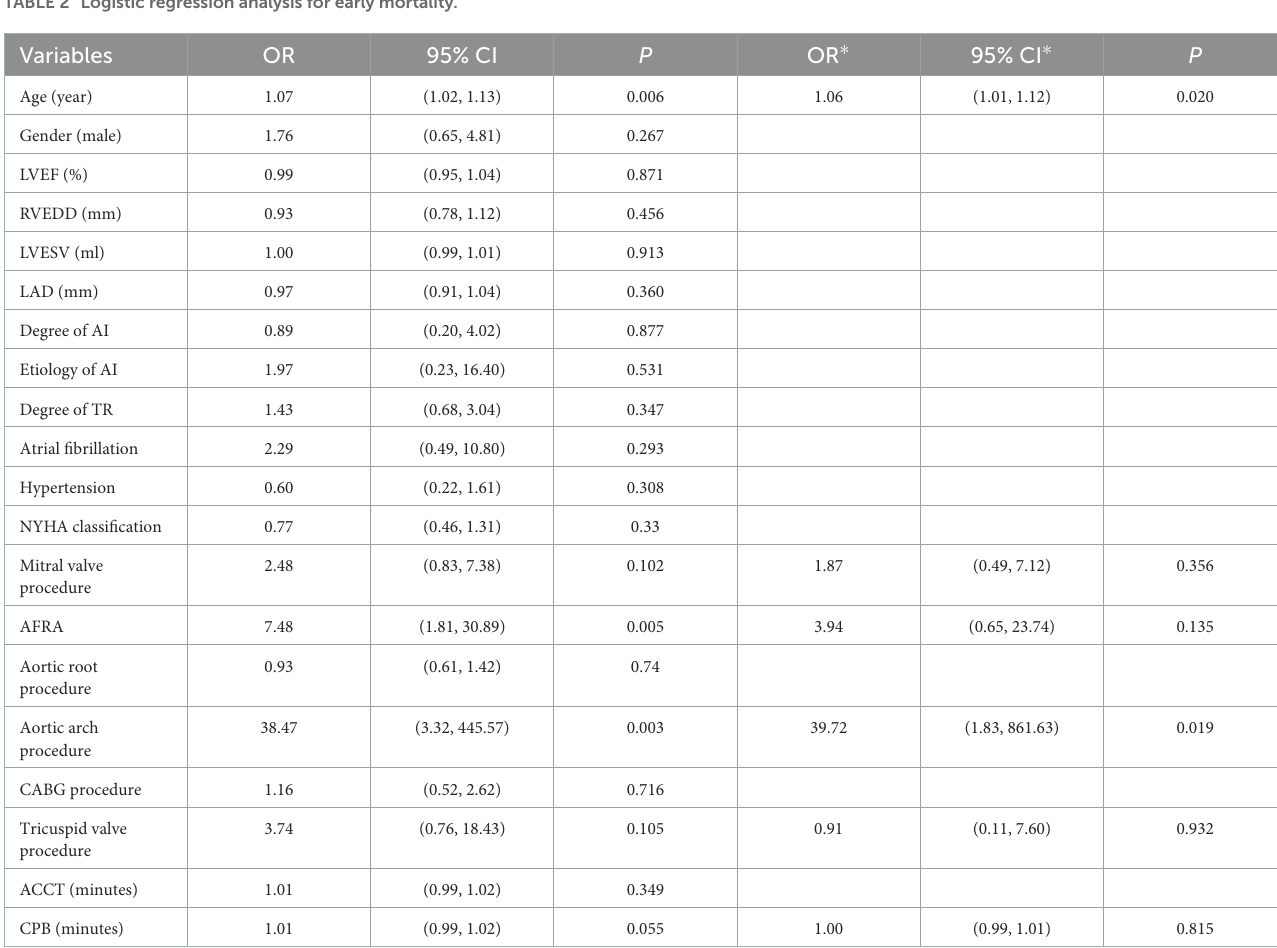
TABLE 2 Logistic regression analysis for early